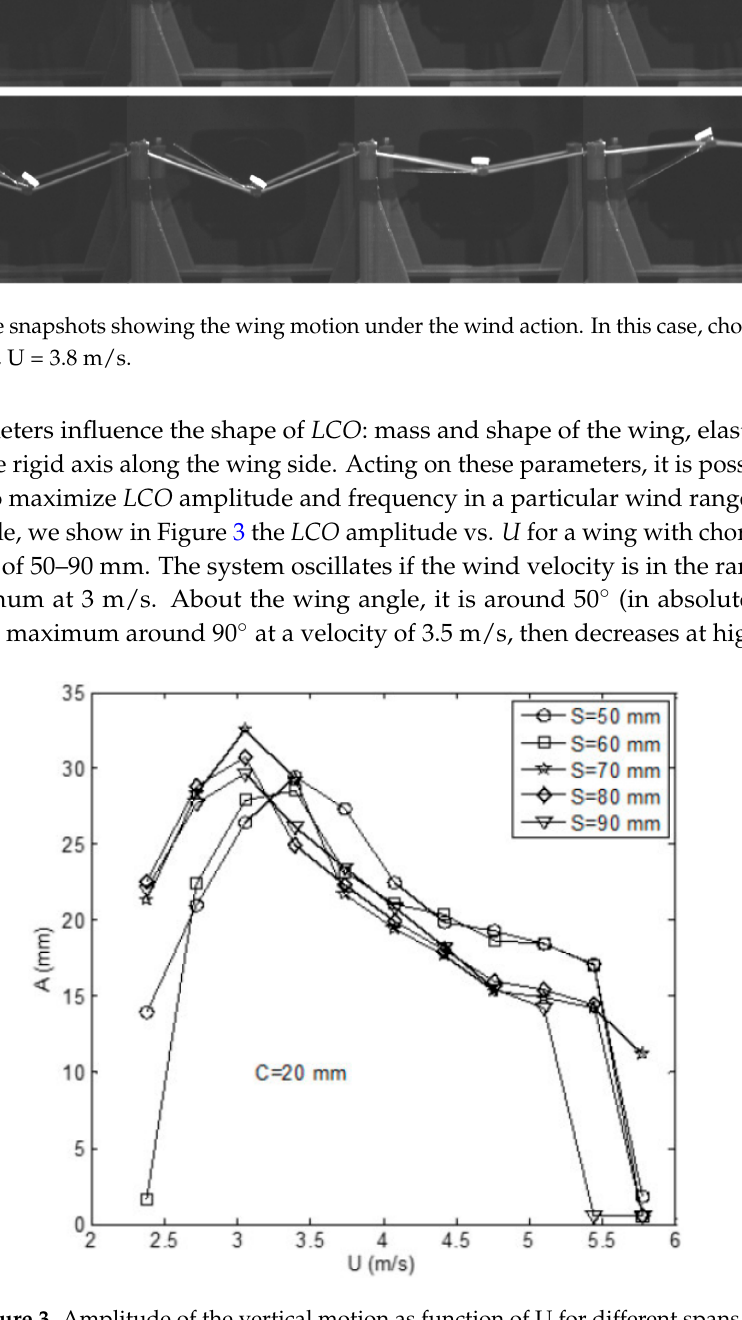
Figure 3. Amplitude of the vertical motion as function of U for different spans.